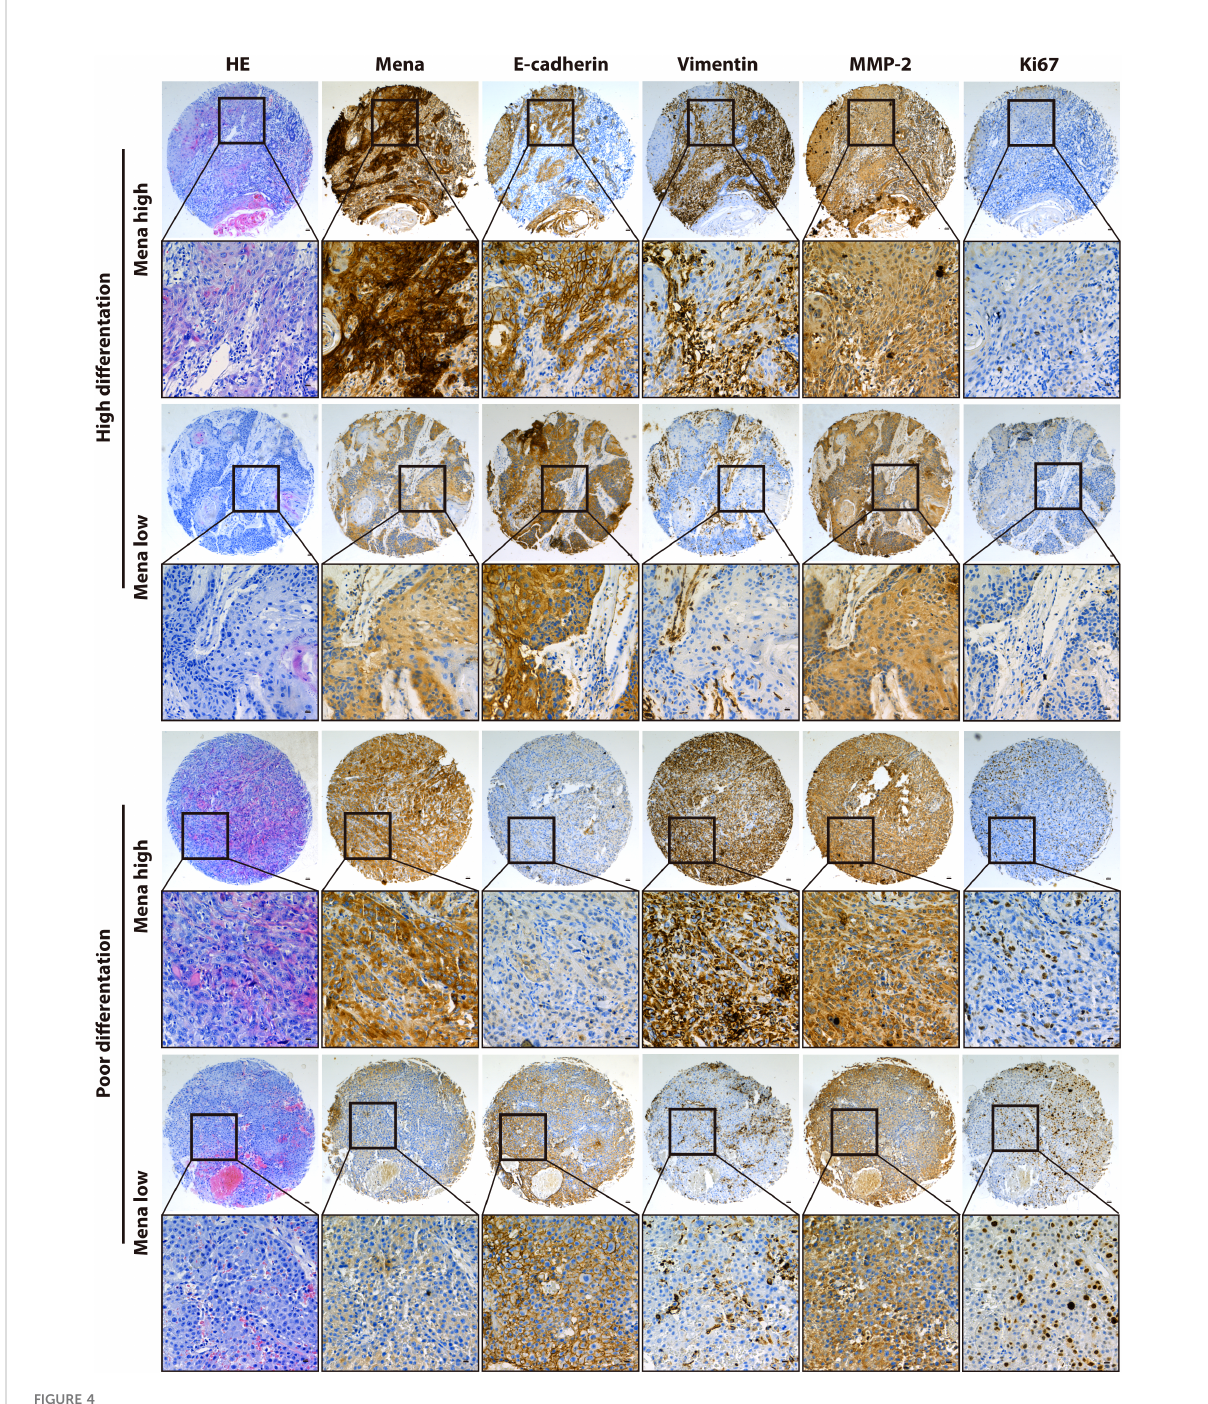
FIGURE 4 Immunohistochemical analysis of Mena protein and tumor-related markers